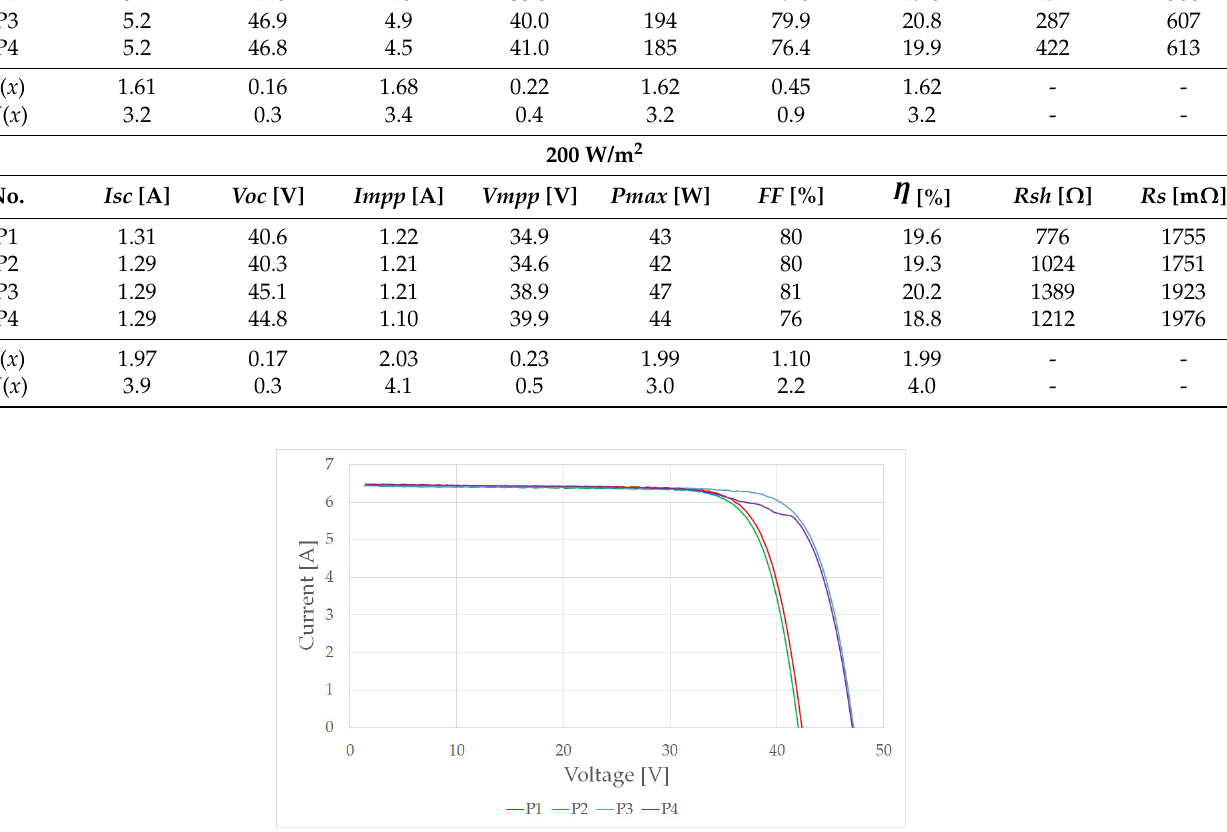
Table 4. Results of electrical parameters measurements for each prototype at different irradiance level with standard and expanded uncertainty. η